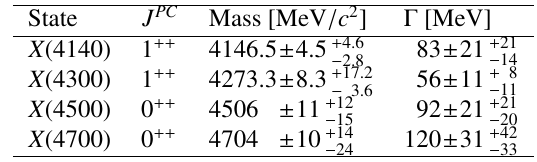
Table 1. Properties of the exotic resonances found in the amplitude analysis of the decay B + → J /ψφ K +